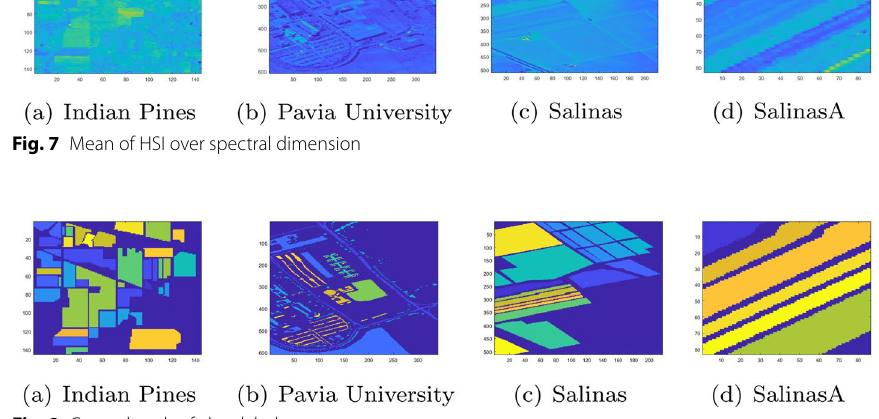
Fig. 8 Ground truth of class